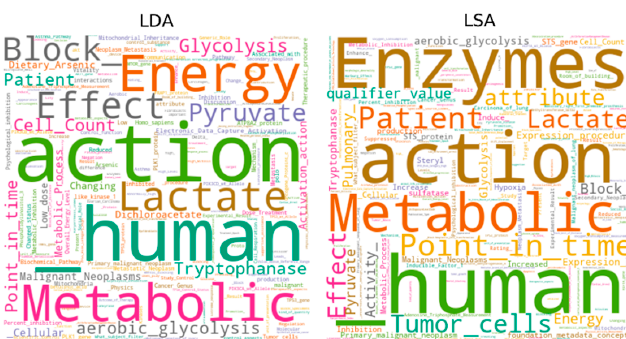
Figure 9. Word cloud of the top-1 topics on the TPI hallmark.